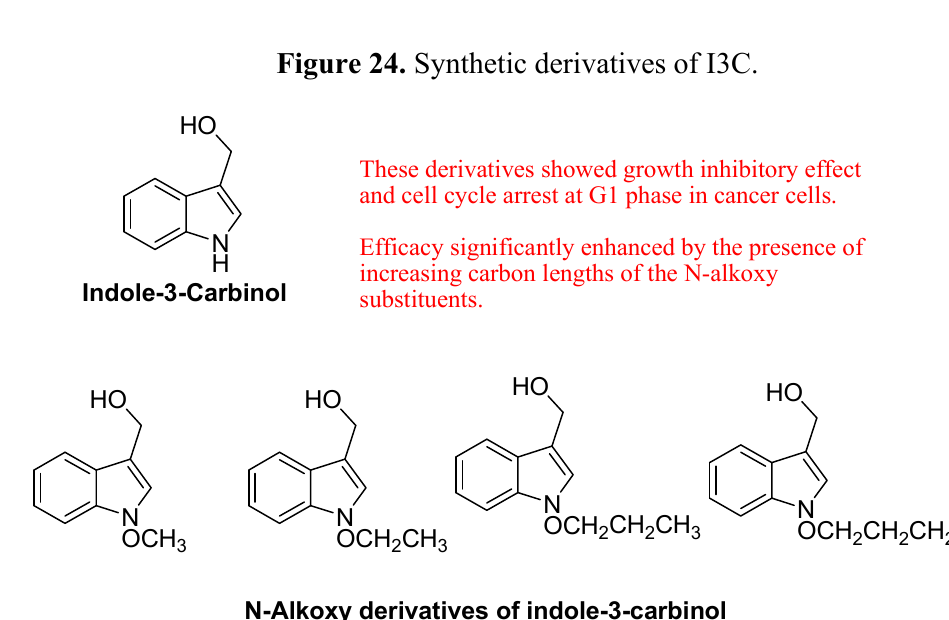
Figure 24. Synthetic derivatives of I3C.